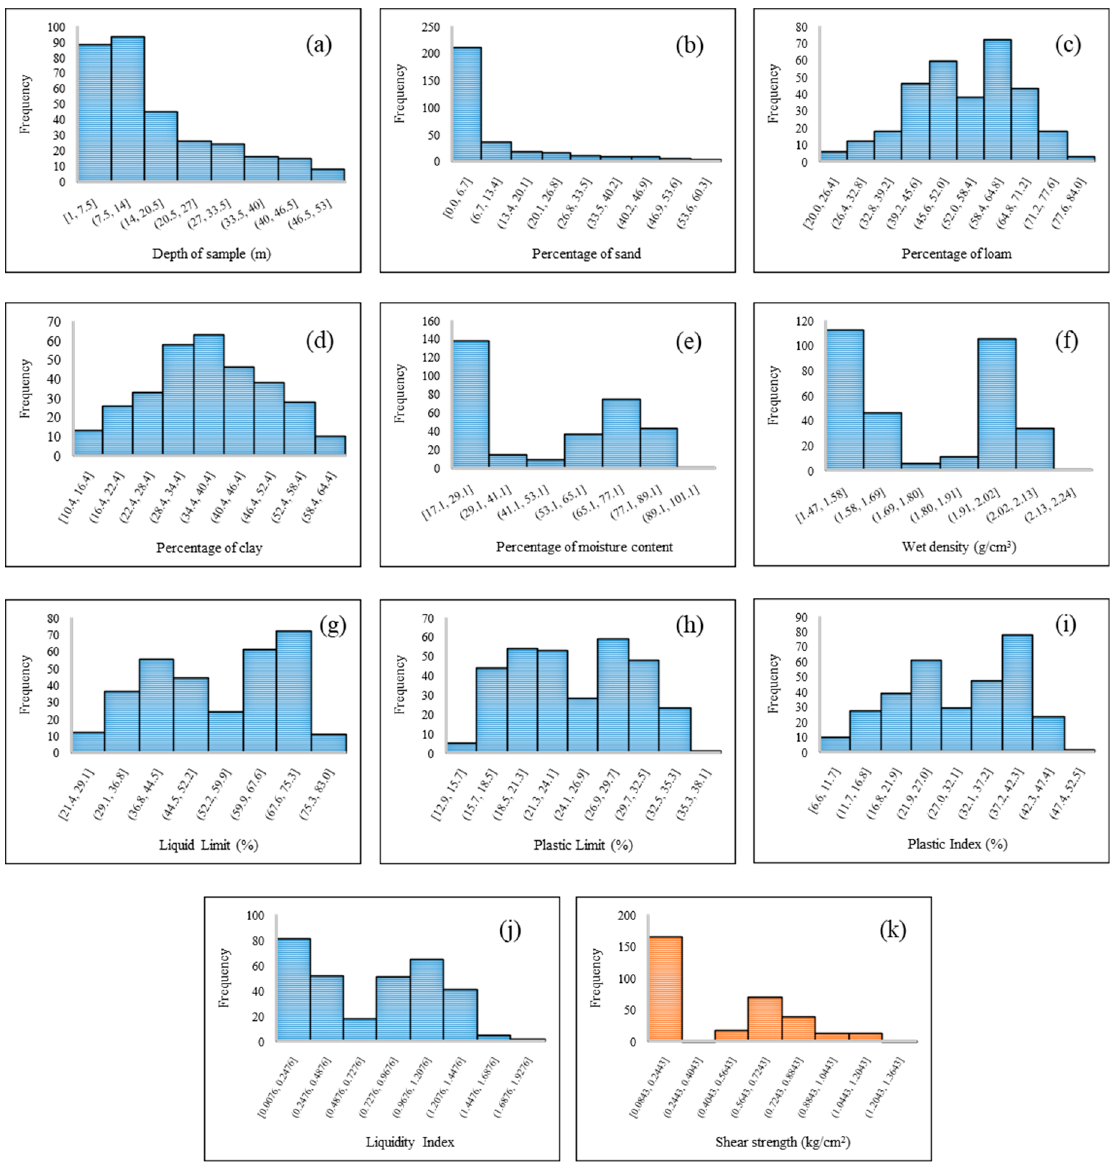
Figure 4. Histogram of ( a ) depth of sample, ( b ) percentage of sand, ( c ) percentage of loam, ( d ) percentage of clay, ( e ) percentage of moisture content, ( f ) wet density, ( g ) liquid limit, ( h ) plastic limit, ( i ) plastic Index, ( j ) liquidity index, and ( k ) shear strength. Table 1. Descriptive statistics of the used dataset.